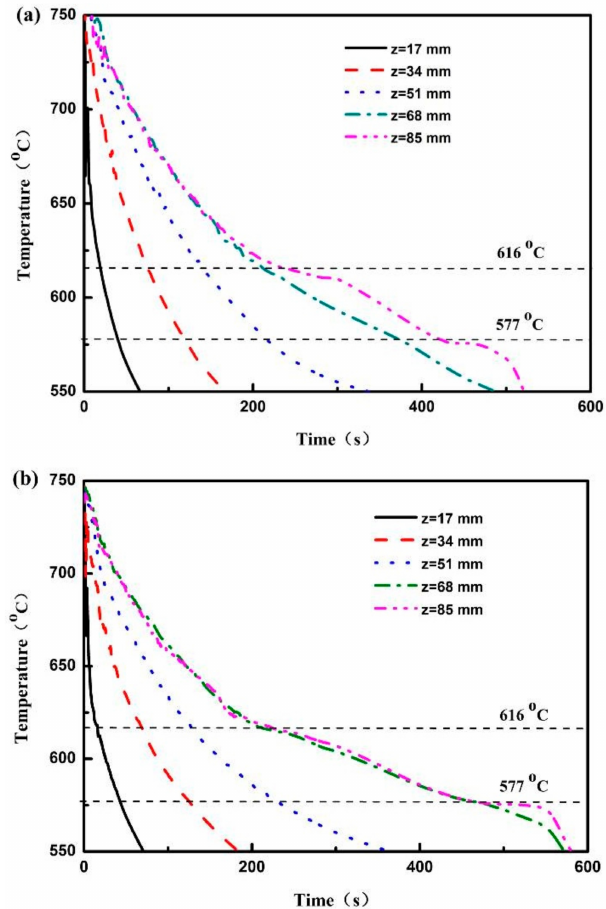
Figure 2. Cooling curves measured during solidification of Al-7Si: ( a ) Without alternating electric current pulse (AECP); ( b ) under AECP with 400 A and 50